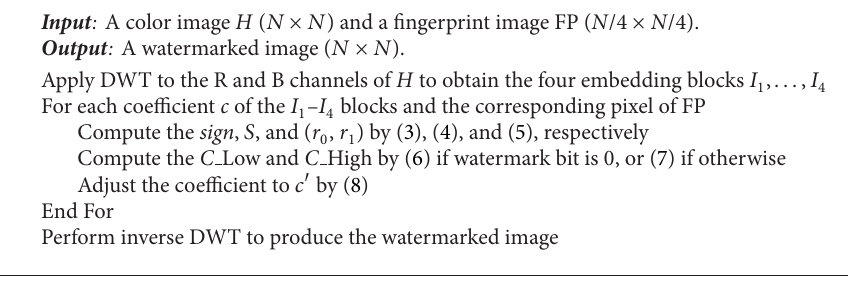
Algorithm 2: Watermark embedding.